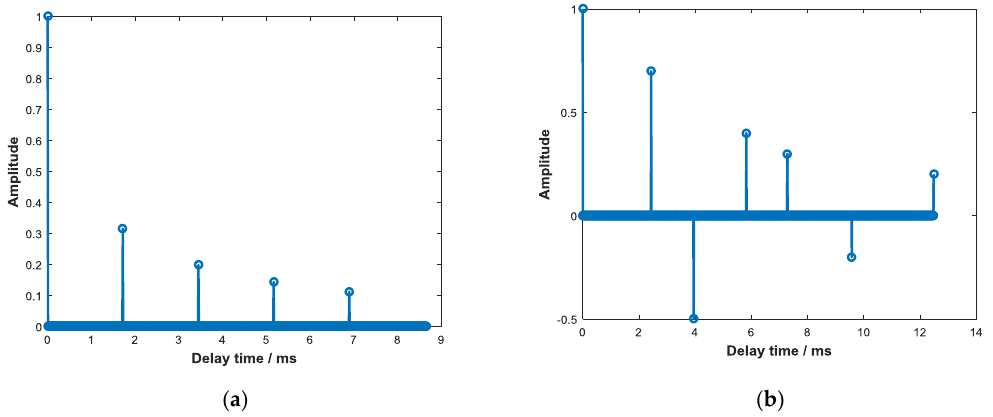
Figure 6. Time domain impulse response of the underwater acoustic channel: ( a ) the channel model 1 ( b ) the channel model 2.